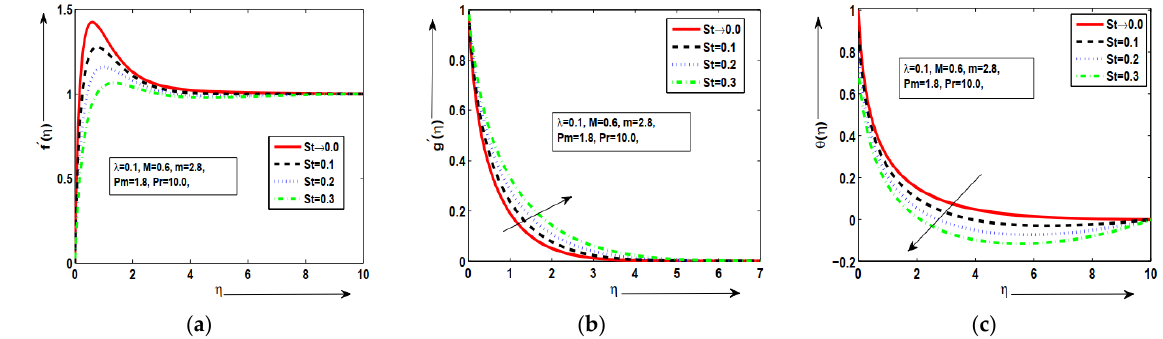
Figure 3. ( a – c ) The geometric profiles of f (cid:48) ( η ) , g (cid:48) ( η ) , and θ ( η ) against St